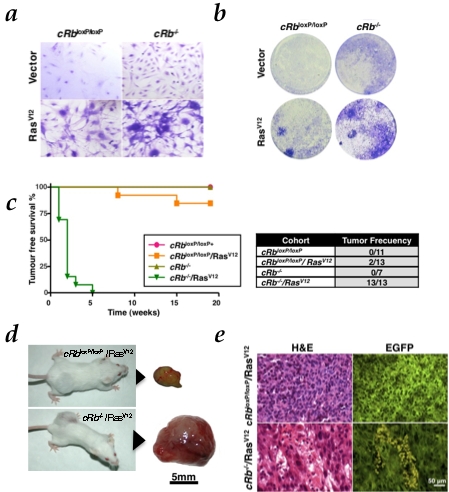
HRasV12 in the absence of Rb induces malignant transformation both in vitro and in vivo.a, Ability to form foci, representative pictures of wells stained with crystal violet (day 7). b, Representative pictures of wells stained on the indicated days of culture showing the morphological change observed in each group are also shown. c, Tumor-free survival curve (Kaplan-Meier plot) for tumor formation in SCID mice. Tumor was found in cRb
−/−/RasV12 cohort (P<0.0001) d, Photographs of SCID mice after subcutaneous injection of cRb
loxP/loxP/RasV12 and cRb
−/−/RasV12 astrocytes at eleven and two weeks respectively. Actual sizes of tumors after biopsy. e. Low-grade gliomas (cRb
loxP/loxP/RasV12; H&E, upper left) showed a rather monomorphic appearance, with polygonal or rounded cell shape and smaller rounded nuclei without prominent nucleoli. Note the absence of mitosis and necrosis. In contrast, high-grade gliomas (cRb−/−/RasV12; H&E, lower left) displayed cellular pleomorphism, with large, fusiform and irregular nuclei that frequently exhibit mitotic figures (upper left corner) and necrotic foci (lower right corner). Co-expression of EGFP permits the visualization of the previously modified astrocytes.